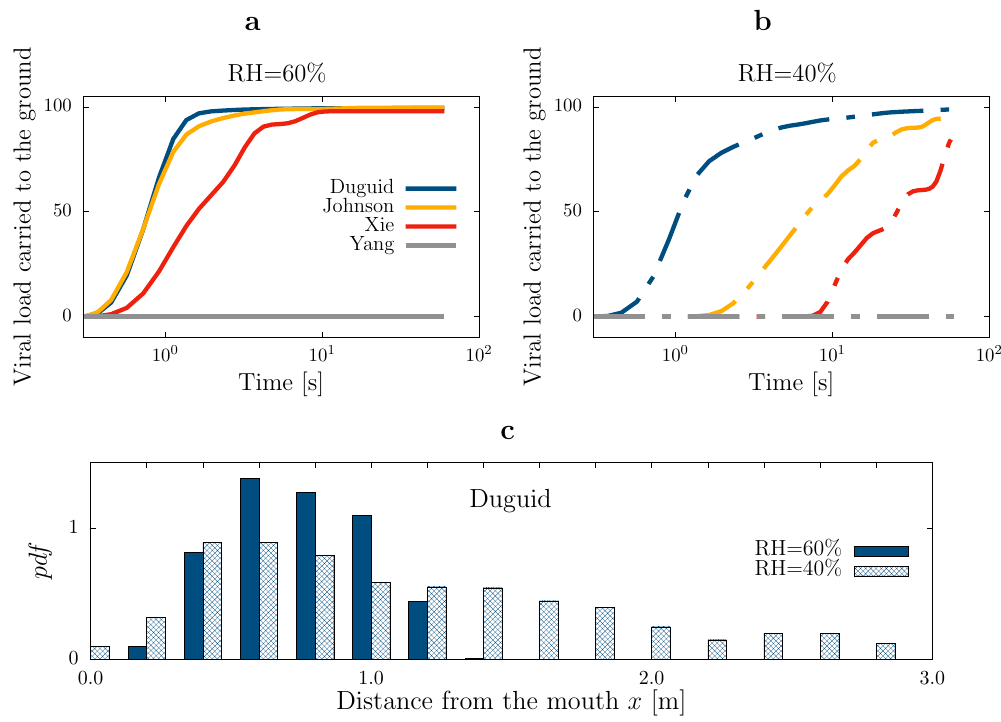
Figure 2. Sedimentation of large droplets. ( a ) Cumulative viral load sedimenting to the ground, obtained with the four different initial droplet size distributions proposed by Duguid 11 (blue), Johnson et al. 16 (yellow), Xie et al. 14 (red) and Yang et al. 15 (gray). Here, the ambient relative humidity is RH = 60 % . ( b ) Same as (a), for a dry environment, RH = 40 % . Most of the viral load settles within 60s for three initial distributions, whereas for one, Yang et al. 15 , no droplets settle within the simulation time. ( c ) Probability density function of the distance from the mouth when droplets reach the ground; ambient relative humidity RH = 60% (solid blue) and RH = 40% (patterned blue). Drier environments cause further spreading: Droplets that reach the ground remain within 1 m from the mouth in wet conditions, whereas they can reach nearly 3m in dry conditions.